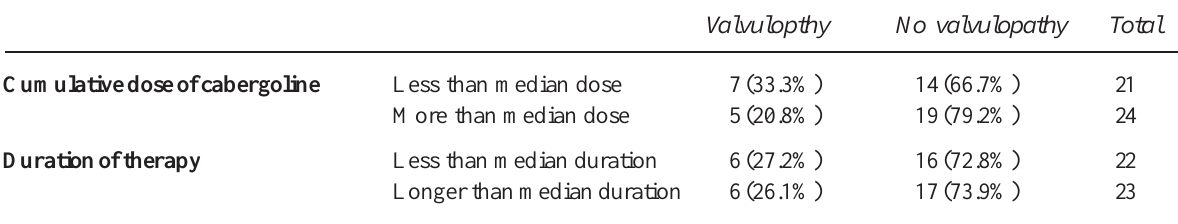
Table 2. Prevalence of valvulopathy with cumulative dose and duration of therapy